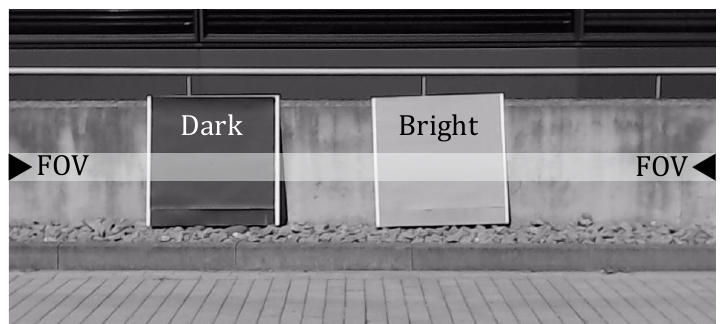
Figure 11. Outdoor target scene measured at 100 klx ambient sunlight including a dark and bright Lambertian target. The distance is measured along the horizontal line in the figure.